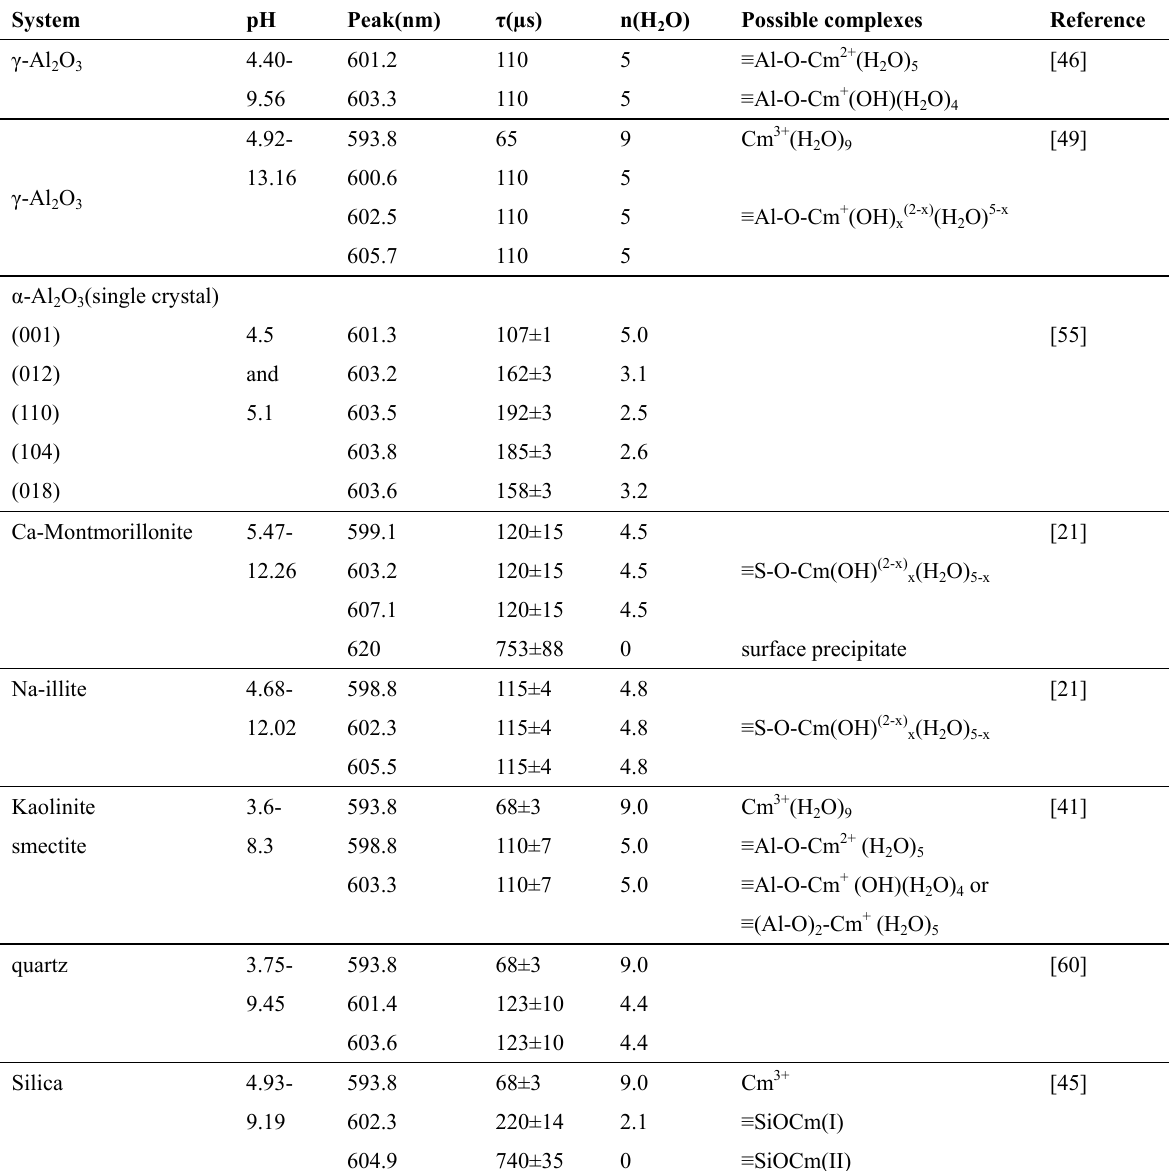
O and clay mineral 2 3